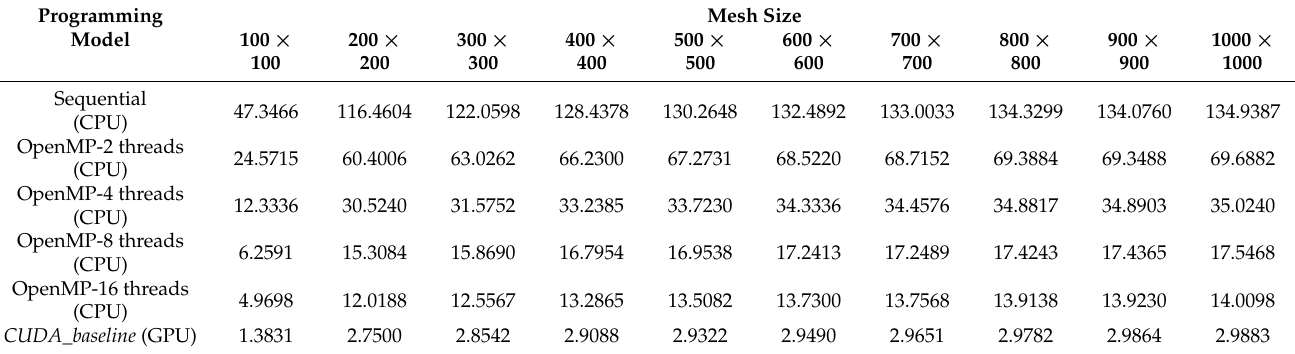
Table 6. Speedup ratio achieved by the CUDA_optimized implementation.